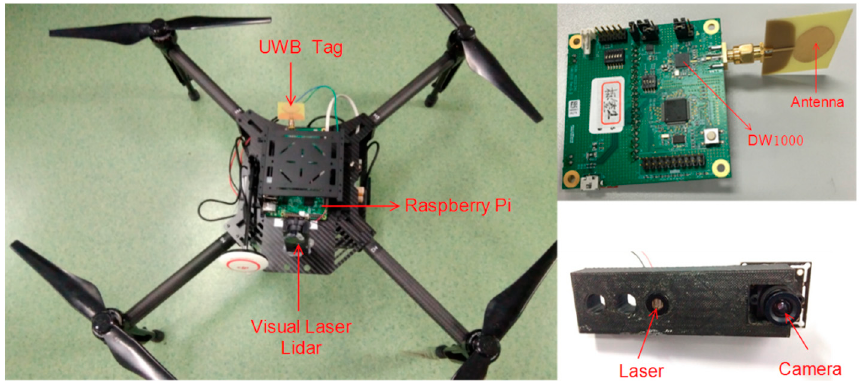
Figure 3. UAV ( left ), UWB ( upper right ) and structured light scanner ( lower right ).